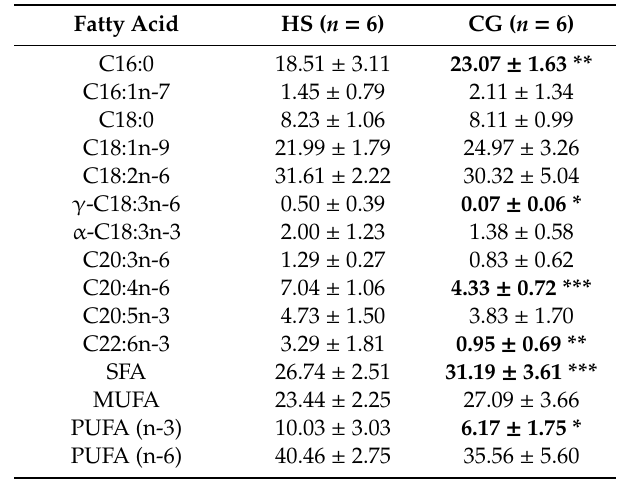
Table 2. Fatty acid composition of the serum from healthy subjects and collapsing glomerulopathy (CG) patients.